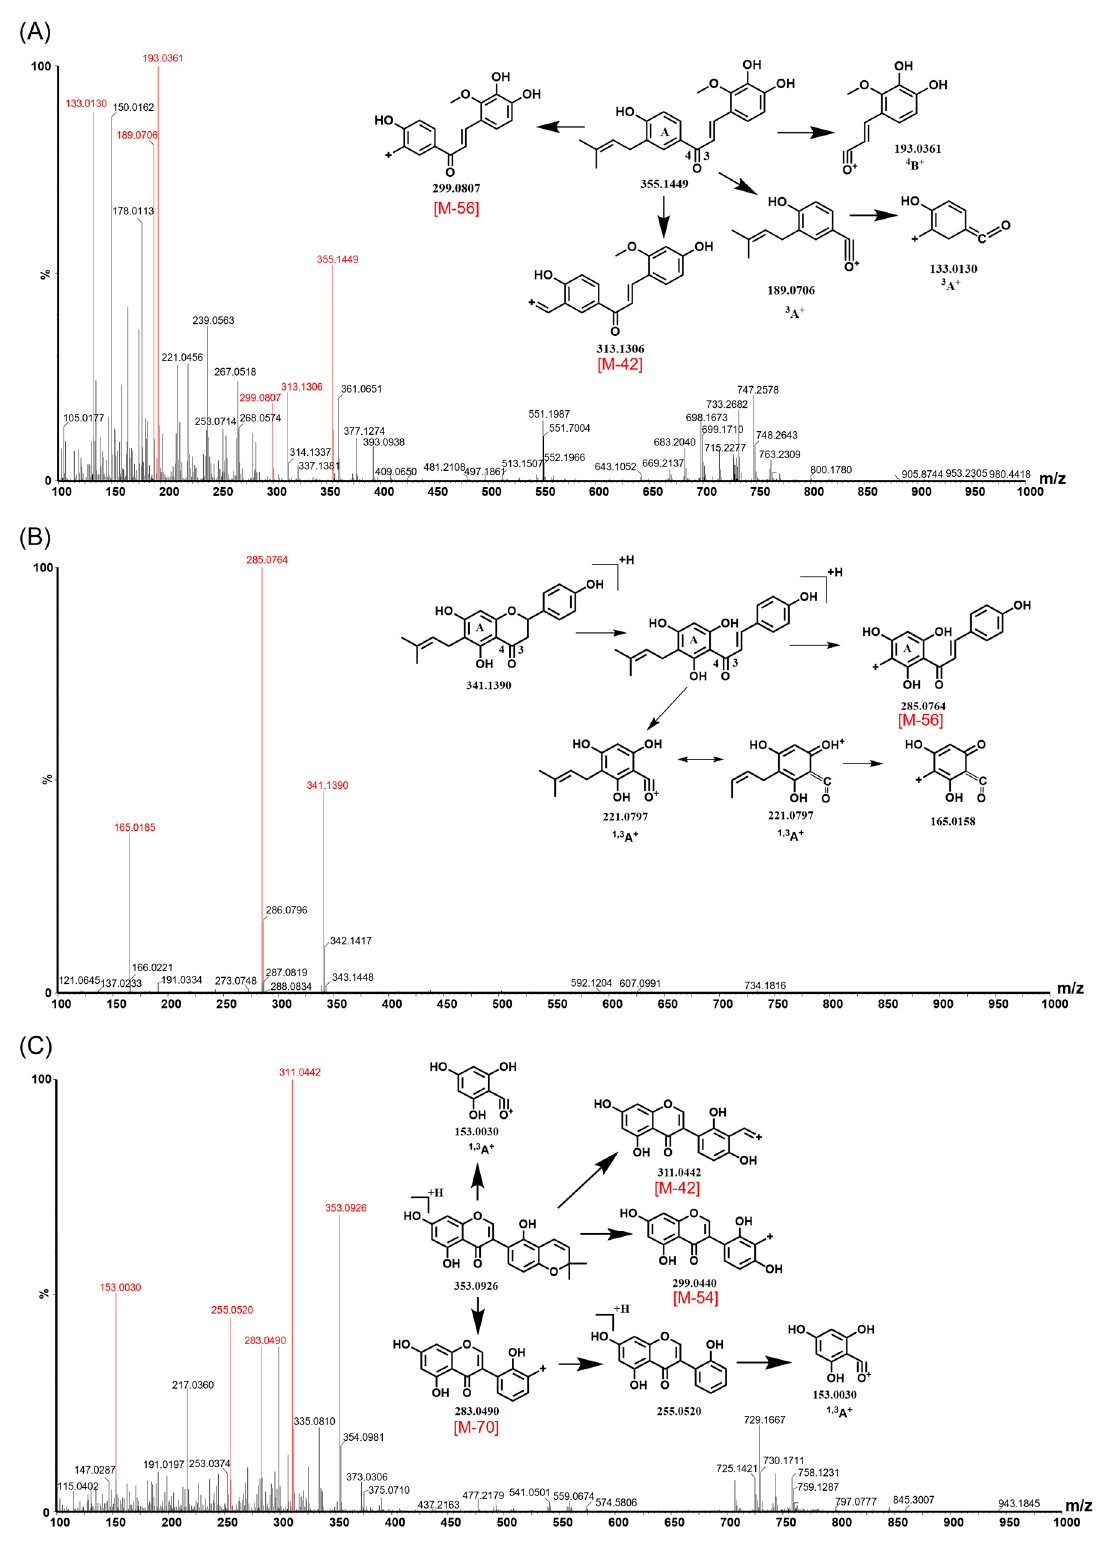
Figure 1. Typical fragment ions and the fragmentation pathway of reference flavonoids in PI mode. ( A ) Licochalcone D; ( B ) 6-prenylnaringenin; ( C ) licoisoflavone B.